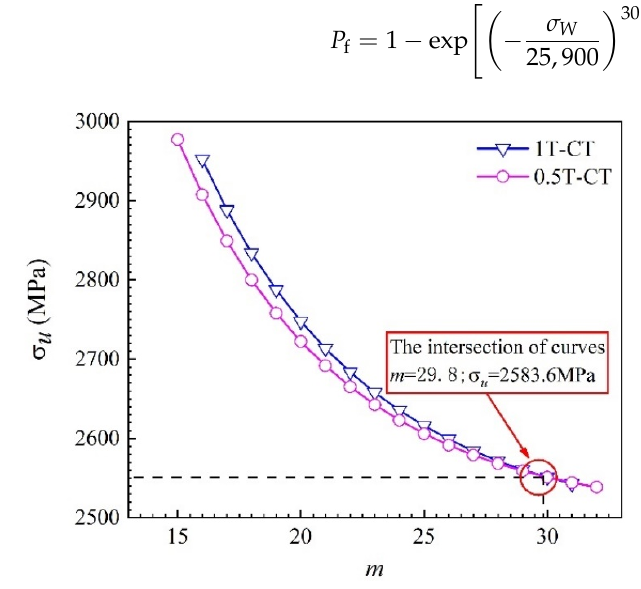
σ curve of 1T-CT and 0.5T-CT samples. Figure 14. m - σ u curve of 1T-CT and 0.5T-CT Figure 14. m - u